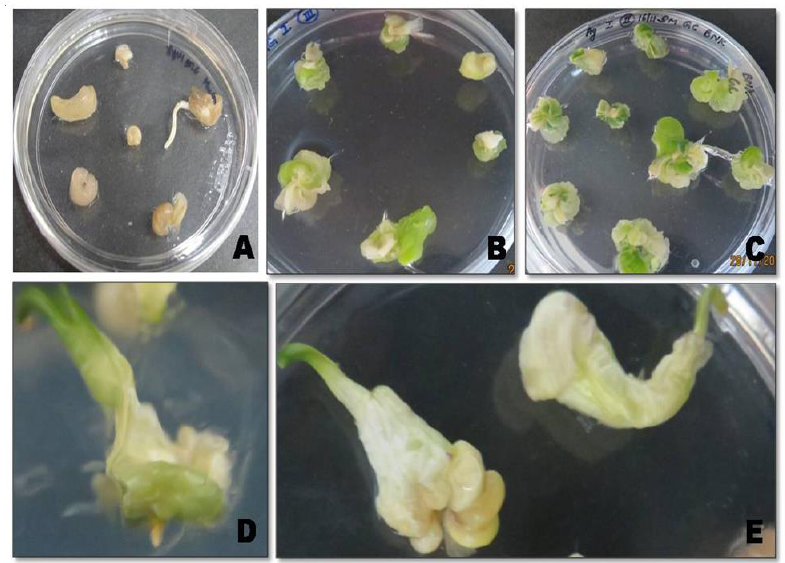
Figure 1. Agrobacterium -mediated transformation in onion calli. ( A ) Wild type calli on selection media; ( B , C ) Transformed calli on selection media (MS+B5 + 1.0 mg L − 1 picloram + 20 mg L − 1 glufosinate-ammonium + 500 mg L − 1 cefotaxime; ( C ) Transformed calli after four rounds of selection; ( D ) Transformed callus on regeneration medium (MS + 0.5 mg L − 1 KIN + 0.5 mg L − 1 BAP + 0.1 mg L − 1 NAA + 20 mg L − 1 glufosinate-ammonium); ( E ) Transformed callus on bulb initiation medium (MS + B5 + 2.0 mg L − 1